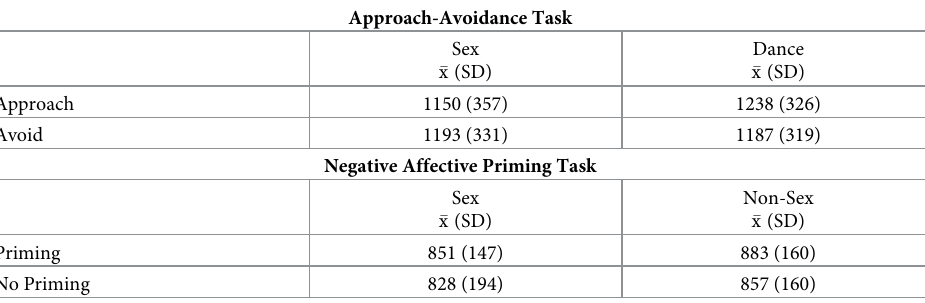
Table 1. Average reaction times of the sexual inhibition tasks